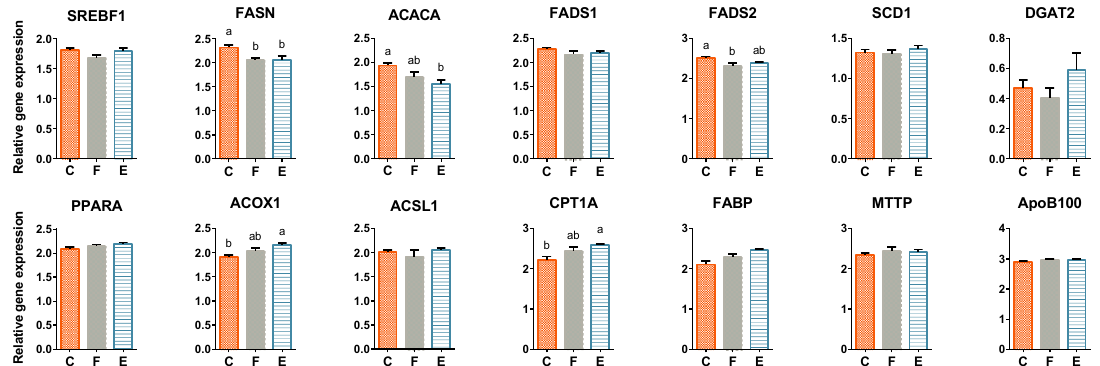
Figure 3. Effect of flaxseed and enzyme supplementation on relative gene expression patterns for select lipid metabolism-related genes in broiler hepatic tissue. Values are log 10 transformed, least square means ± standard errors of the mean. Labels a–b denote significant difference ( p < 0.05) among treatments. C, F and E represent corn-soybean meal basal diet (C, Control), and basal diet with 10% whole flaxseed (F, Flax) plus 0.05% enzyme (E, Flax+E).